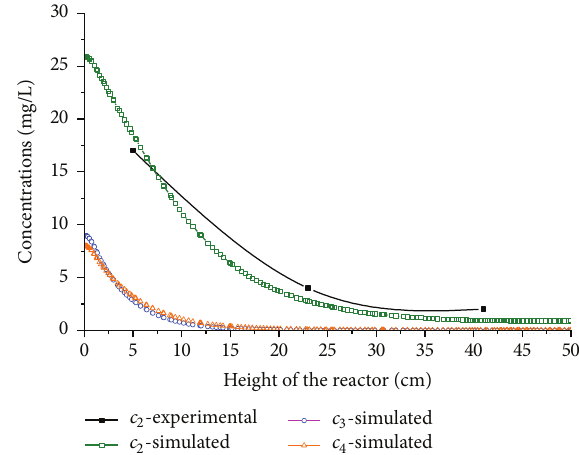
Figure 3: Verification of integrated hydrodynamic and biokinetics in sludge